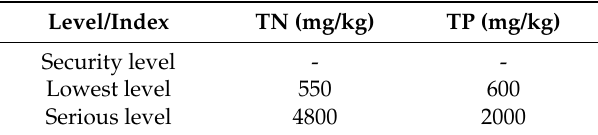
Table 6. Evaluation standard of Nitrogen and Phosphorus in the